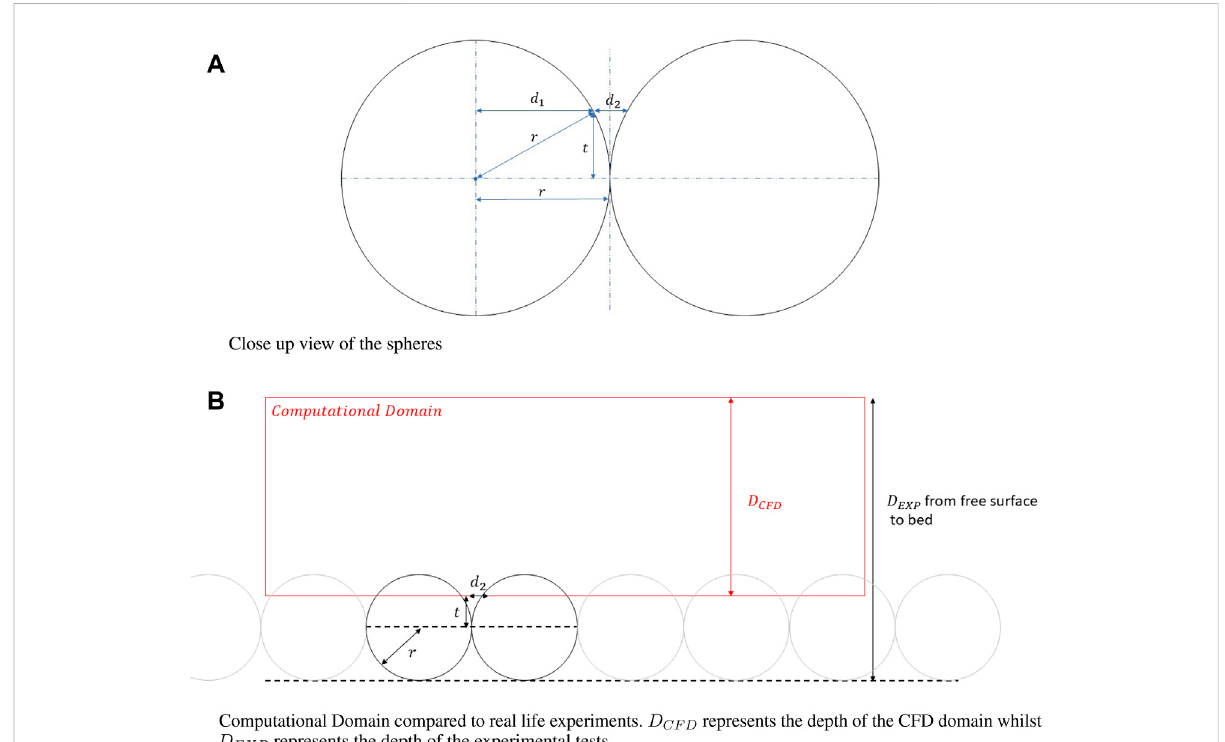
FIGURE 3 Diagram showing thesubmergence of thevirtual bed below thebed ofspherical roughness elements. r is theradius of thespherical roughness element, d 2 isthedistancebetween thespherical roughnesselements atagiven distance t abovethecenterline ofthespheresand d 2 istheadjacent lengthoftherightangletriangleformedbythesidesmakred r and t .Eq.2statesgeometricrelationsbetweenthesevariables toenablecalculation of t . (A) Close up view of the spheres (B) Computational Domain comparedto real life experiments. D CFD represents thedepth of theCFD domain whilst D EXP represents the depth of the experimental tests.